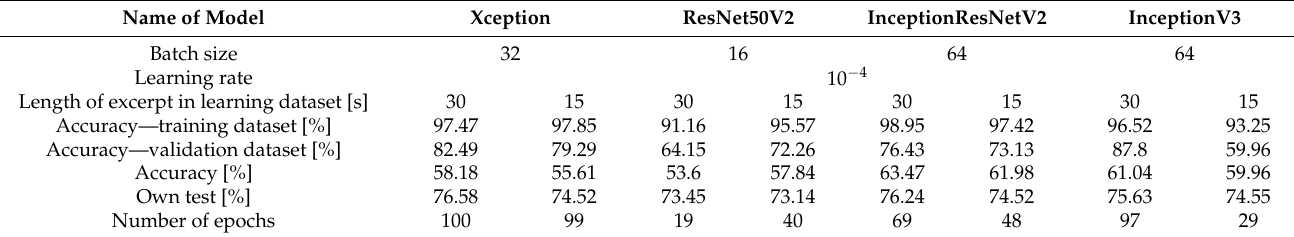
Table 9. Results of the third stage of the NN training.